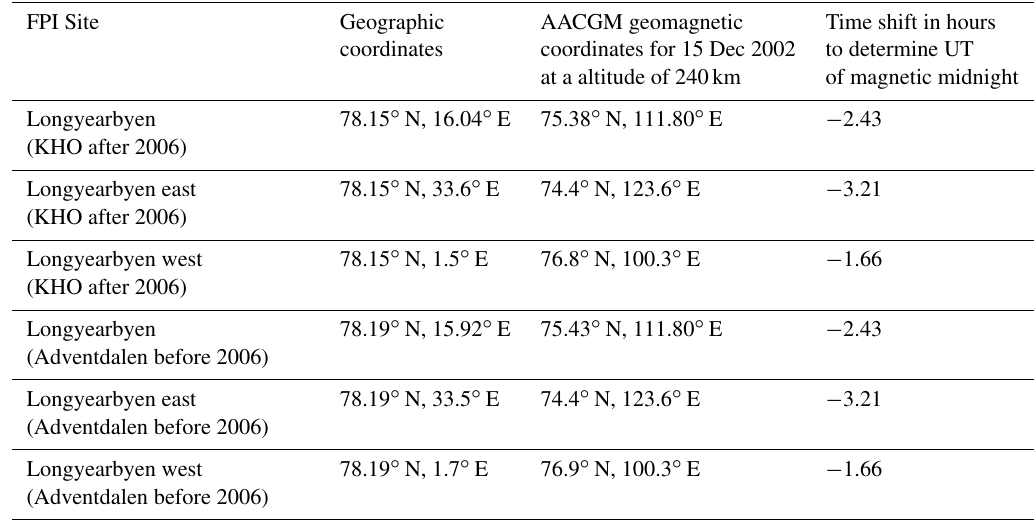
Table 2. The same as in Table 1, but for the FPI site in Longyearbyen. The observatory’s historic names are given in parentheses. FPI Site